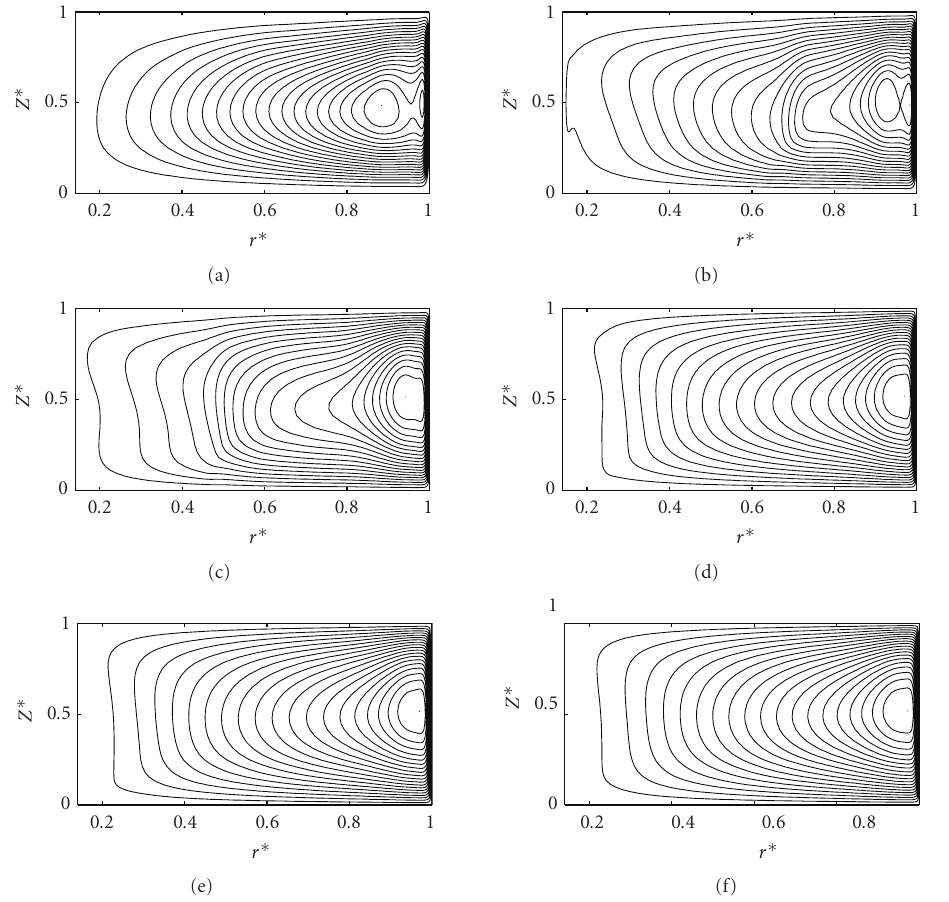
Figure 9: Influence of the Reynolds number on the streamline patterns Ψ ∗ (20 contours) for G = 0 . 02 and six values of Re: (a) 1 . 8 × 10 5 , − 0 . 31 ≤ Ψ ∗ ≤ 76 . 89; (b) 5 × 10 5 , − 0 . 66 ≤ Ψ ∗ ≤ 60 . 59; (c) 10 6 , − 0 . 63 ≤ Ψ ∗ ≤ 48 . 19; (d) 3 × 10 6 , − 0 . 41 ≤ Ψ ∗ ≤ 39 . 16; (e) 5 × 10 6 , − 0 . 32 ≤ Ψ ∗ ≤ 36 . 92; (f) 10 7 , − 0 . 23 ≤ Ψ ∗ ≤ 34 .